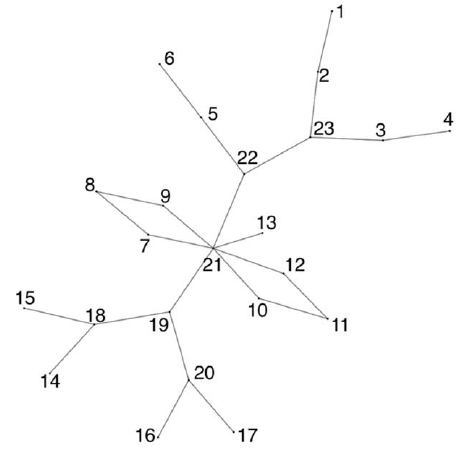
Sensors 2023 , 23 , x FOR PEER REVIEW